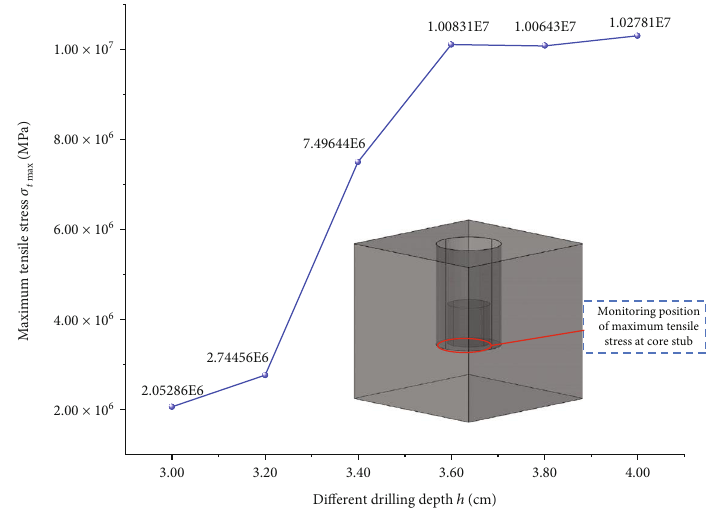
ff erent drilling depths. t max with di